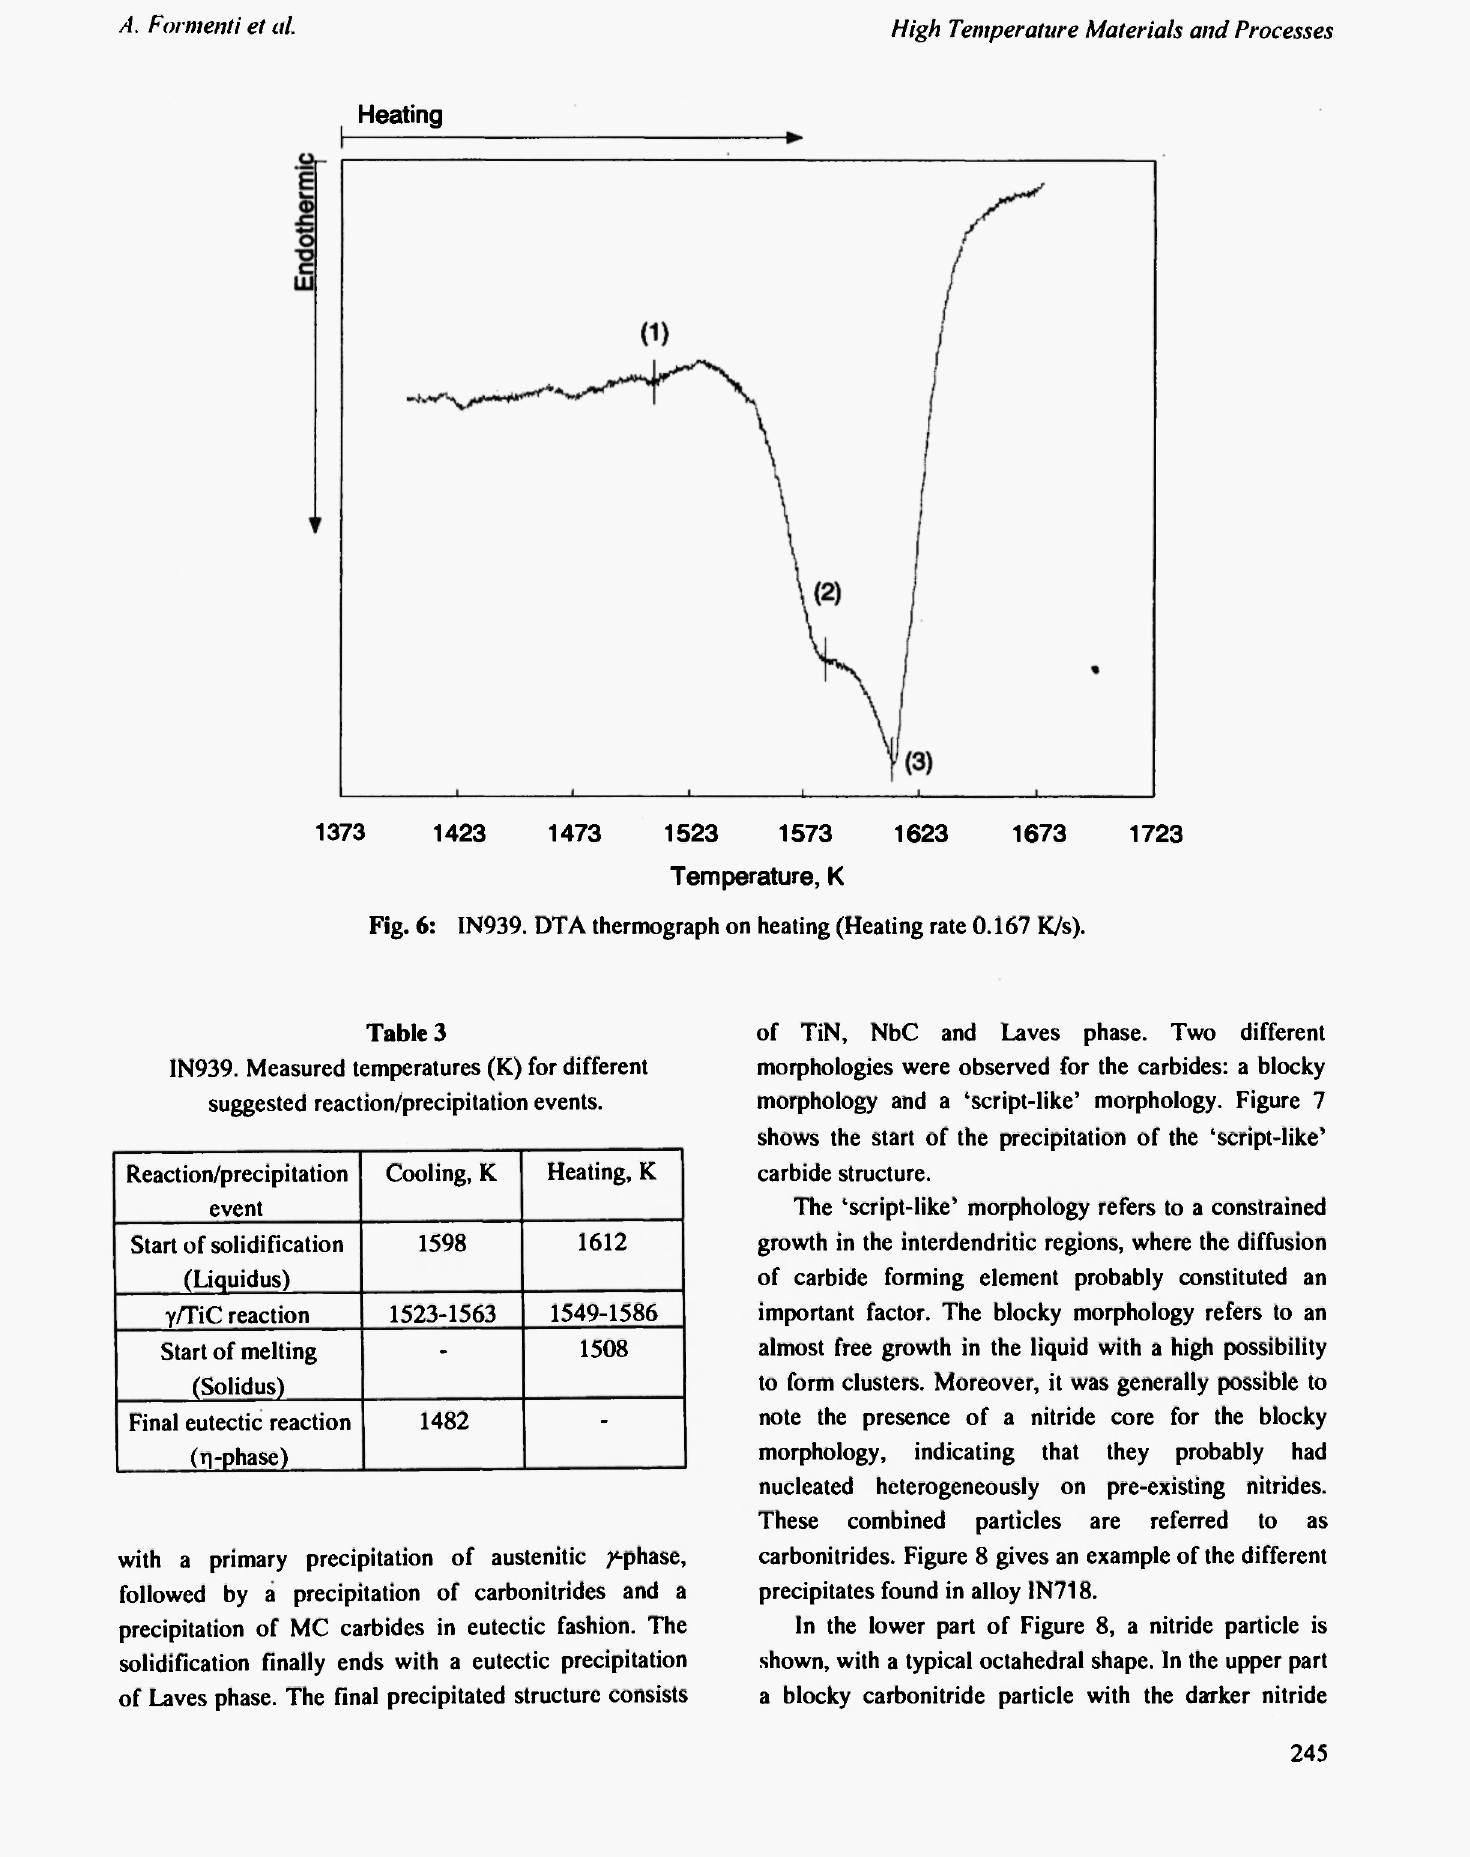
Fig. 6: ΙΝ939. DTA thermograph on heating (Heating rate 0.167 K/s).